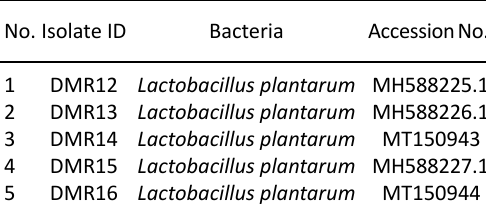
Table 4. Bacterial isolates, their 16S identities and